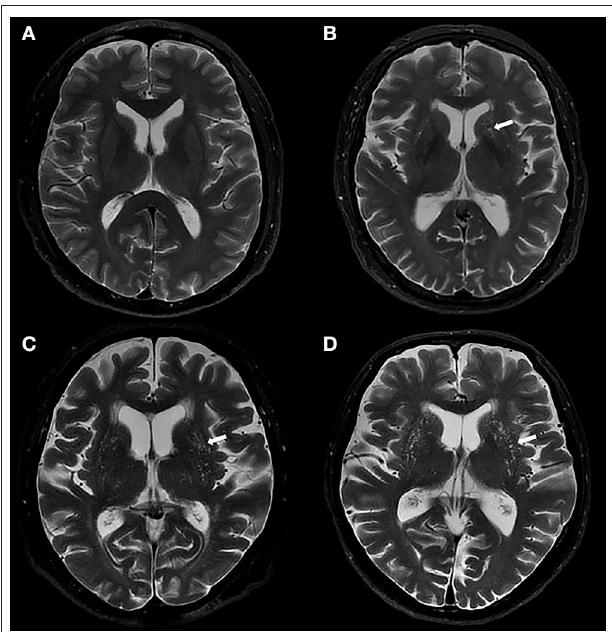
FIGURE 2 | Examples of MRI-visible BG-PVS. (A,B) Axial T2-weighted images show the mild grade of BG-PVS (arrow), (C,D) Axial T2-weighted images show the severe grade of BG-PVS